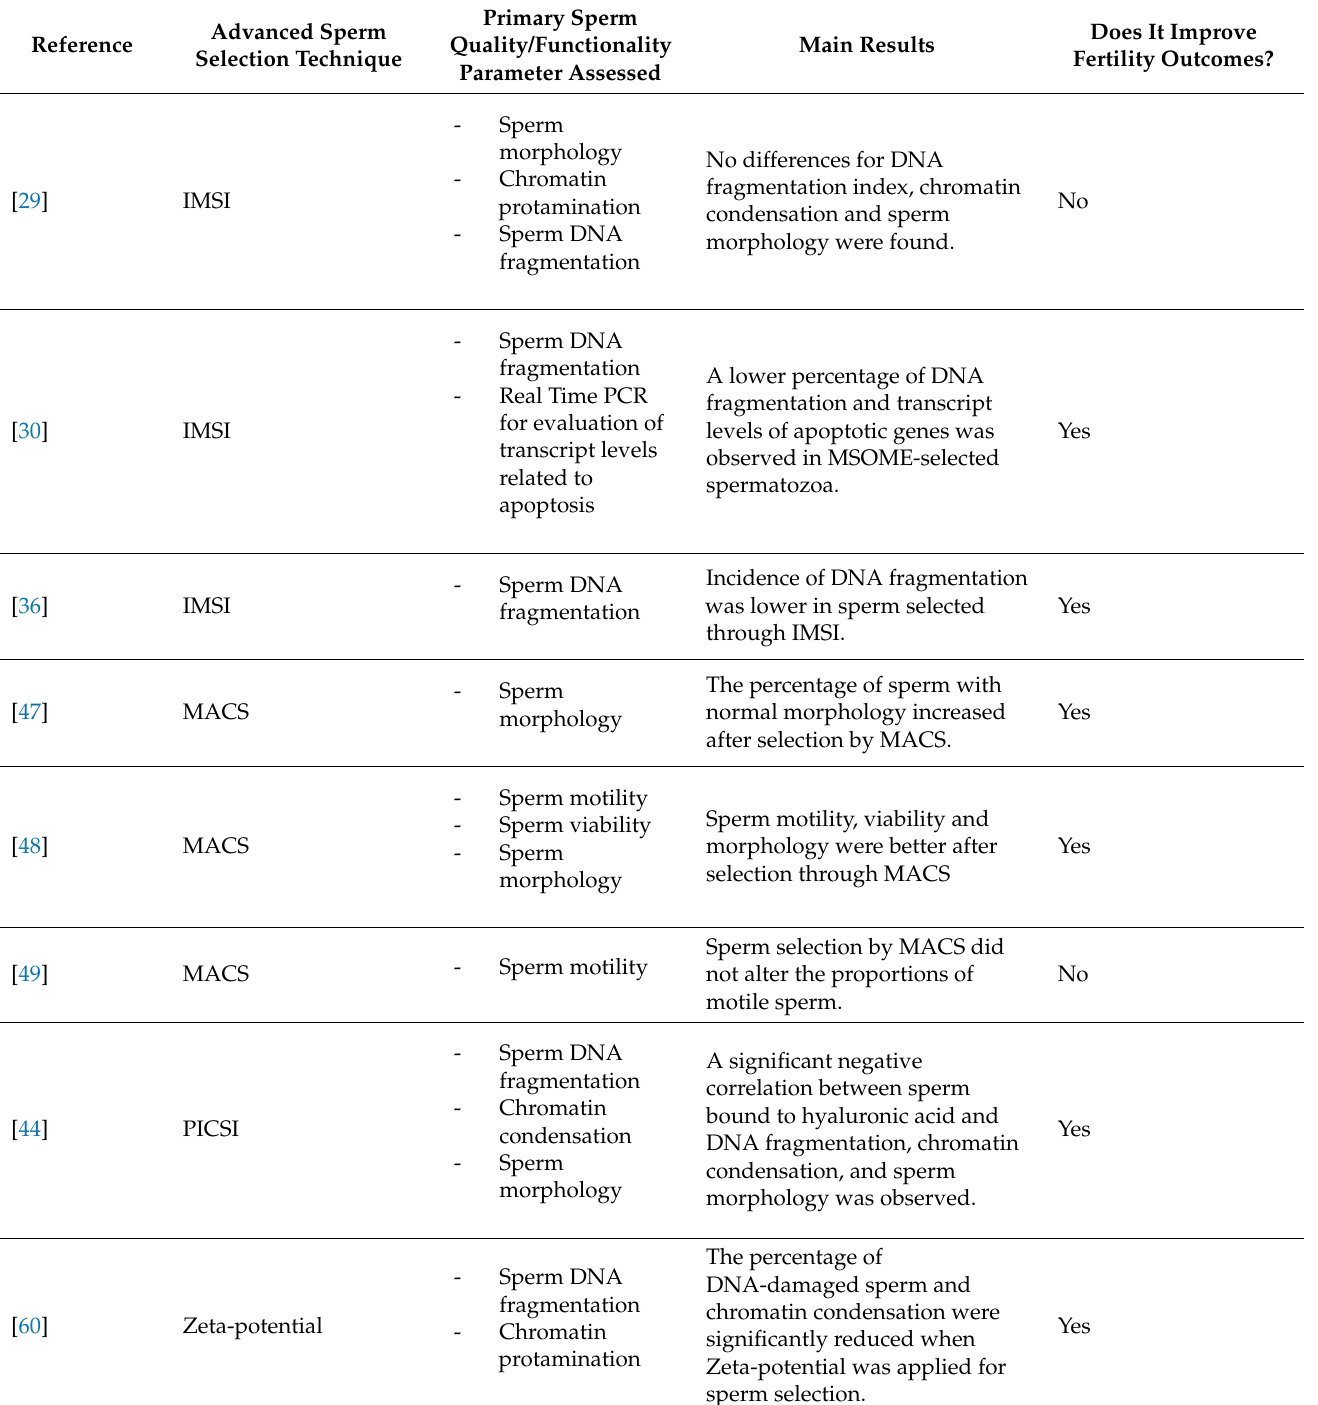
Table 3. Summary of all included research articles performing sperm quality analysis before and after the selection method. Abbreviations: IMSI: intra-cytoplasmic morphologically selected sperm injection; MACS: magnetic-activated cell sorting; MSOME: motile sperm organelle morphology examination; PICSI: physiological intra-cytoplasmic sperm